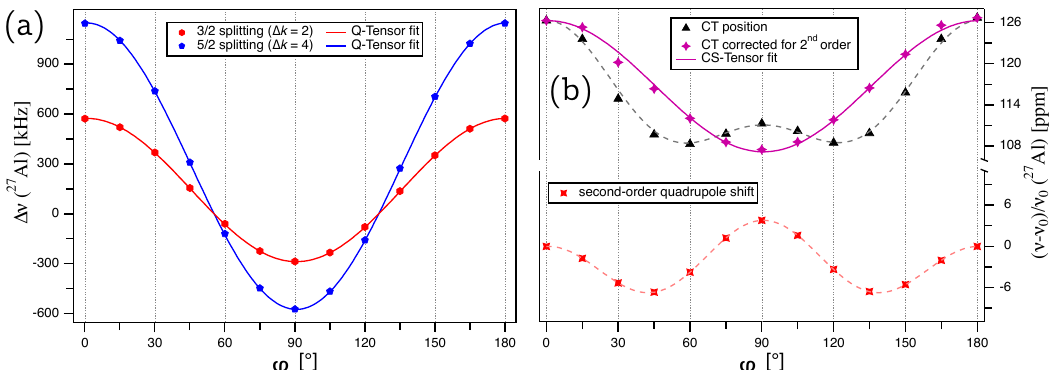
Figure 3. ( a ) Plot of the splittings ∆ ν ( k ) = ν (+ k ) k ) for the ST(3/2) ( ∆ k = 2; red) and ST(5/2) ( ∆ k = 4; blue) doublets for 27 Al in the unit cell of the AlN single crystal. The lines represent the fit of the quadrupole coupling tensor according to Equation (9). ( b ) Plot of the experimentally determined central transition for 27 Al ( k = 0; black), the contribution of the quadrupolar interaction according to Equation (7) (red), and the central transition after subtracting the quadrupolar second-order shift from the experimental data points (purple). The solid purple line represents the fit of the chemical shift tensor according to Equation